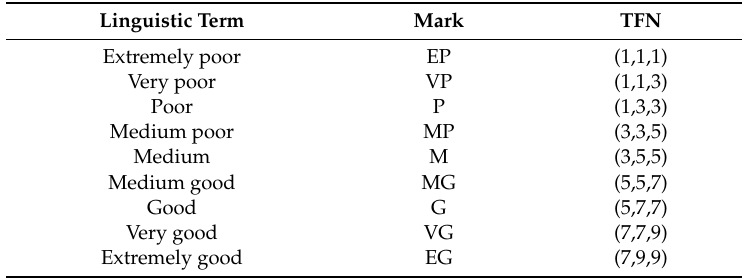
Table 1. A newly defined scale for evaluating potential solutions.